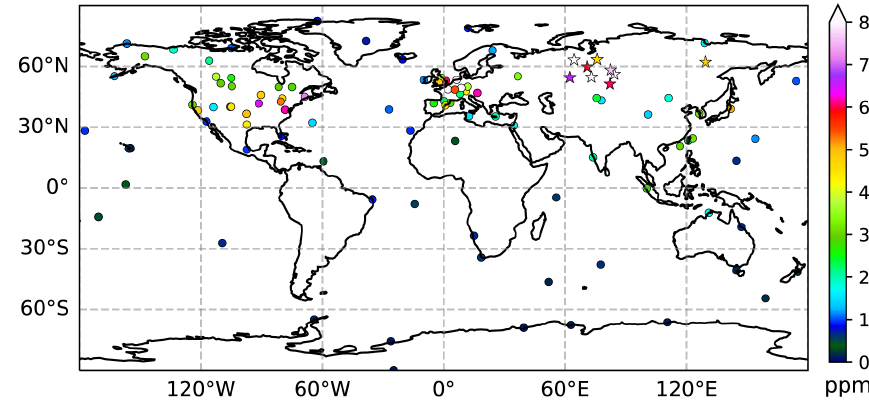
Figure 3. The location of the surface pseudo-observations. The dots are the locations of the GLOBALVIEW-CO 2 observations, and the pentagram is the location of the AMES tower observations. The colors indicate the representative errors assigned to each station. Table 1. Summary of the nature run, control run, and assimilation run experimental setup. We conducted three different assimilation ex- periments using LETKF (L), LETKF together with CEnKF applied to ensemble mean (LC), and LETKF together with CEnKF applied to ensemble members (LCE). Note that the interannual variation and annual mean source and sink information in the SiB3 have been subtracted.